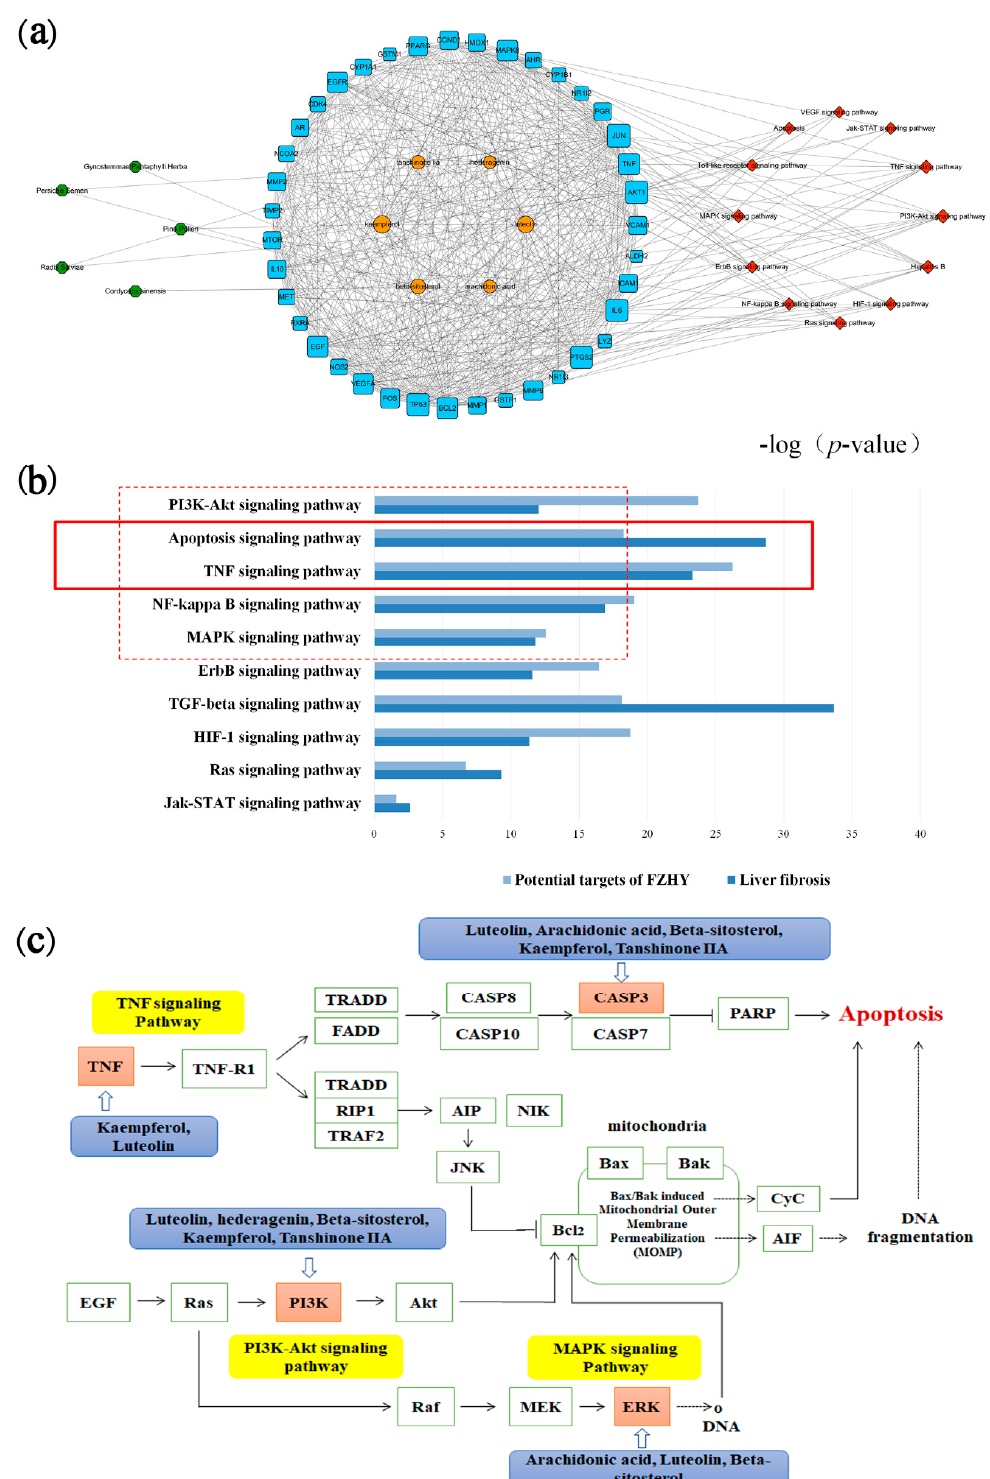
Figure 2. Network pharmacology analysis. ( a ) Herb-compound-target-signaling pathway of FZHY. The green octagon nodes represent herbs, the orange ellipse nodes represent compounds, the blue square nodes represent targets and the red diamond nodes represent signaling pathways. ( b ) Top 10 shared signaling pathways of potential targets of FZHY and liver fibrosis. ( c ) Putative major signaling pathways of FZHY. The blue rectangles represent compounds, the yellow rectangles represent signaling pathways, the squares represent targets, and the orange squares represent predicted targets. FZHY, FZHY